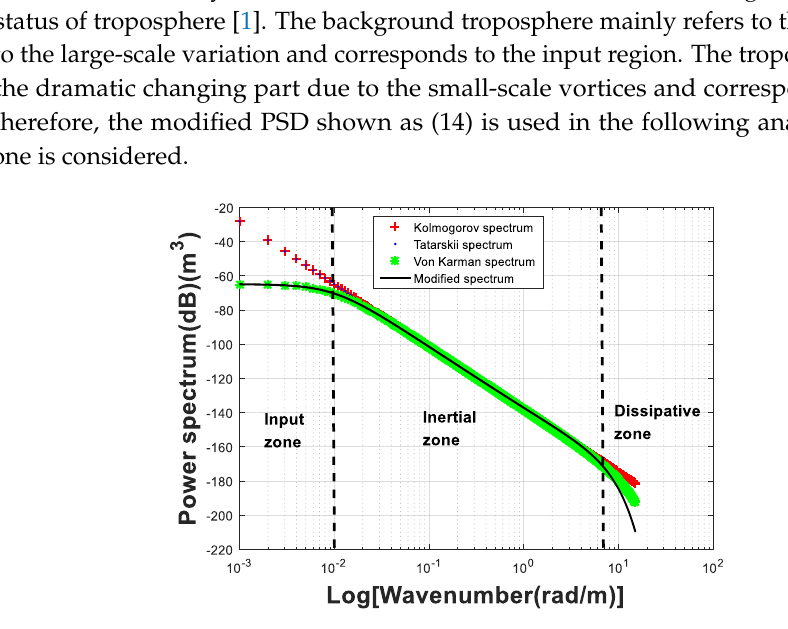
Figure 5. The refractivity structure spectrum Φ n ( κ )